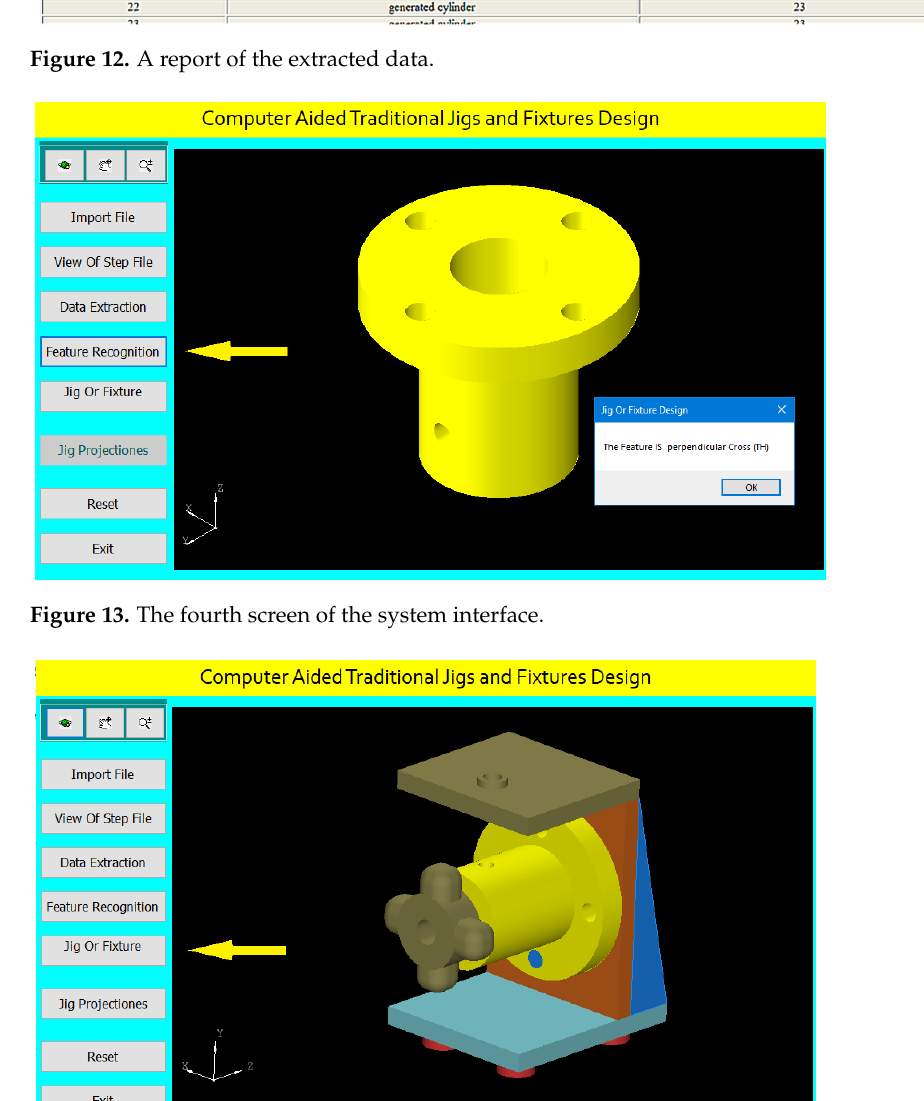
Figure 12. A report of the extracted data.